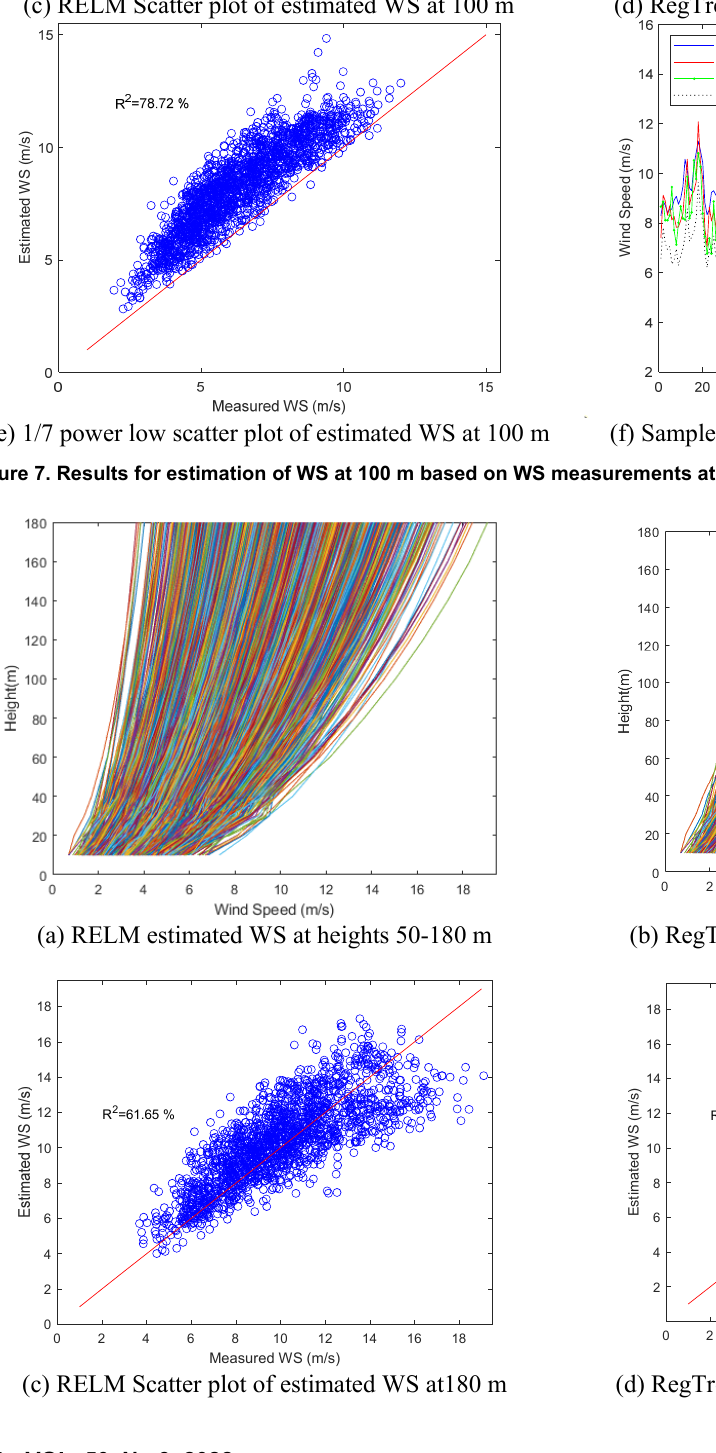
(c) RELM Scatter plot of estimated WS at 100 m (d) RegTree Scatter plot of estimated WS at 100 m